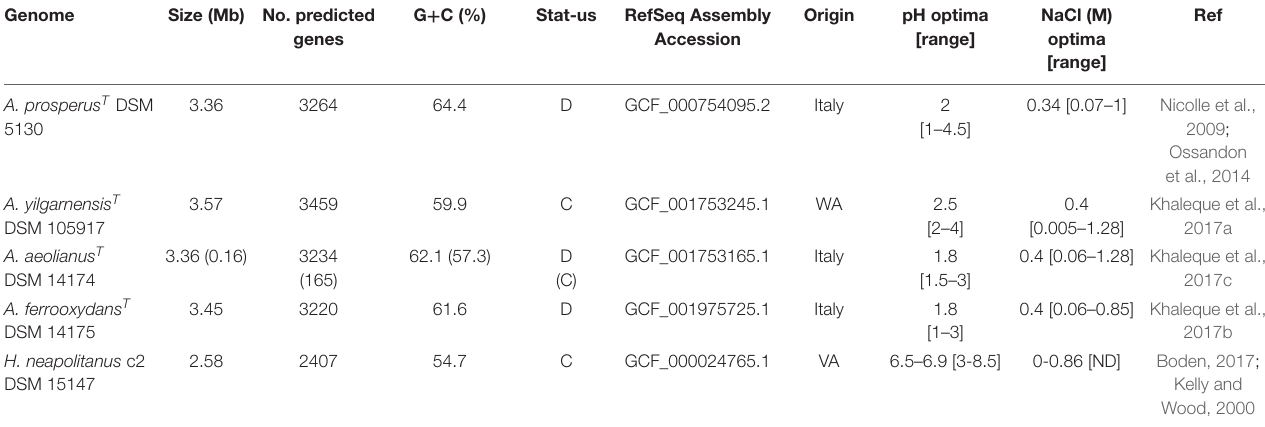
TABLE 1 | Genomic information of the Acidihalobacter spp. genomes and Halothiobacillus neapolitanus genome used in the study. Genome Size (Mb) No. predicted